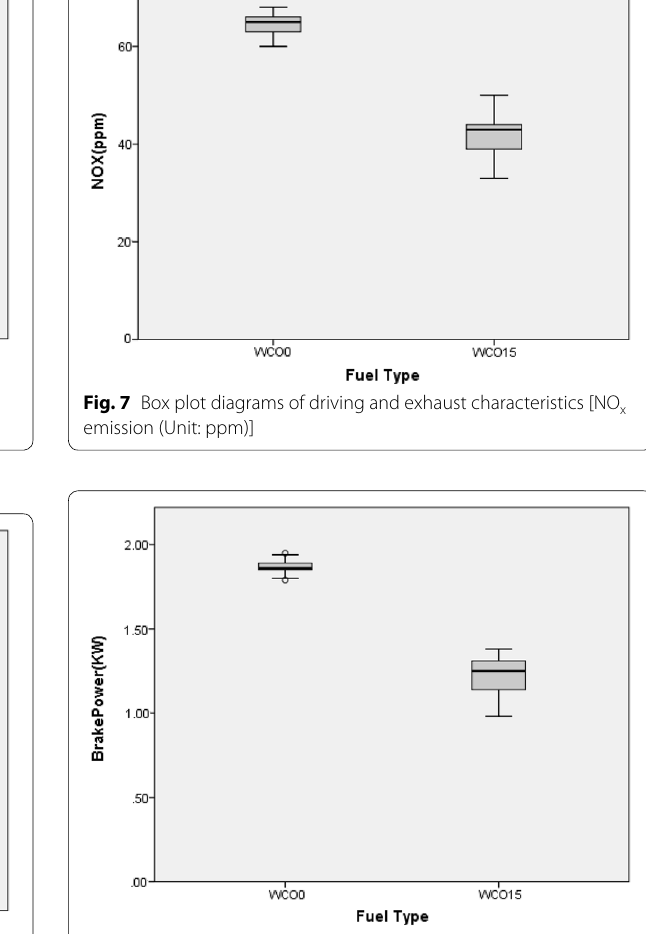
Fig. 8 Box plot diagrams of driving and exhaust characteristics [Brake power (Unit: kW)]